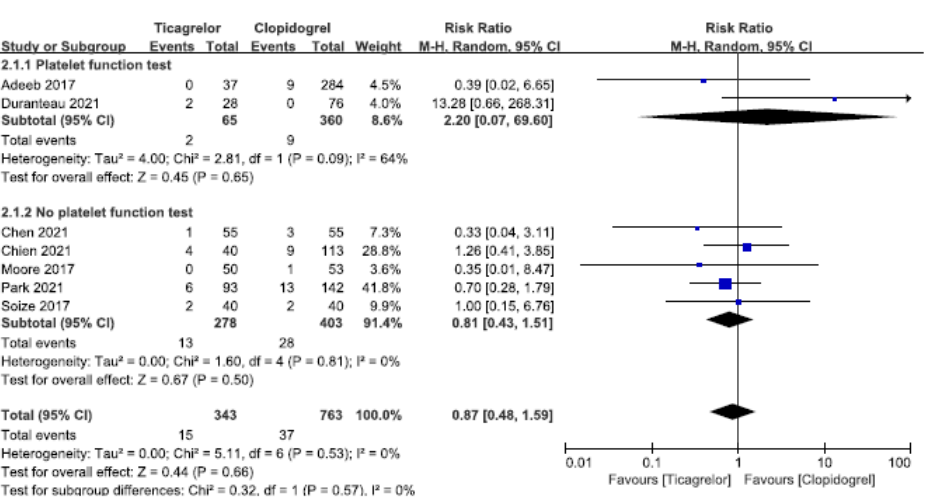
Figure 4. Forest plots of the meta-analysis comparing hemorrhagic complications between ticagrelor and clopidogrel treatment. Top, the studies with platelet function test, and the subgroup analysis for the patients with clopidogrel resistance study. Bottom, the studies with no platelet function test. Subgroup analysis showed that only 2 [22,28] studies simultaneously measured platelet function and monitored hemorrhagic complications. Ticagrelor did not increase the incidence of hemorrhagic complications in patients with clopidogrel resistance (RR =